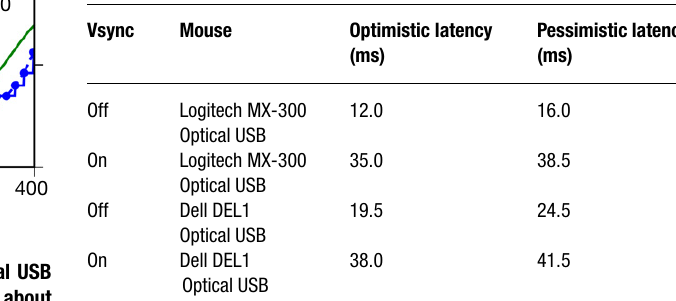
Table 1 | Latency as estimated by the peak of the cross correlation between mouse location and displayed point location. Optimistic laten- cies were estimated using the cross correlation with the linearly interpolated display positions as plotted in Figure 5 and described in Section “Timing of Visual Stimuli: Measurements of Latency.” Pessimistic latencies were also estimated with a cross correlation, but used a sample-and-hold function rather than linear interpolation to estimate display